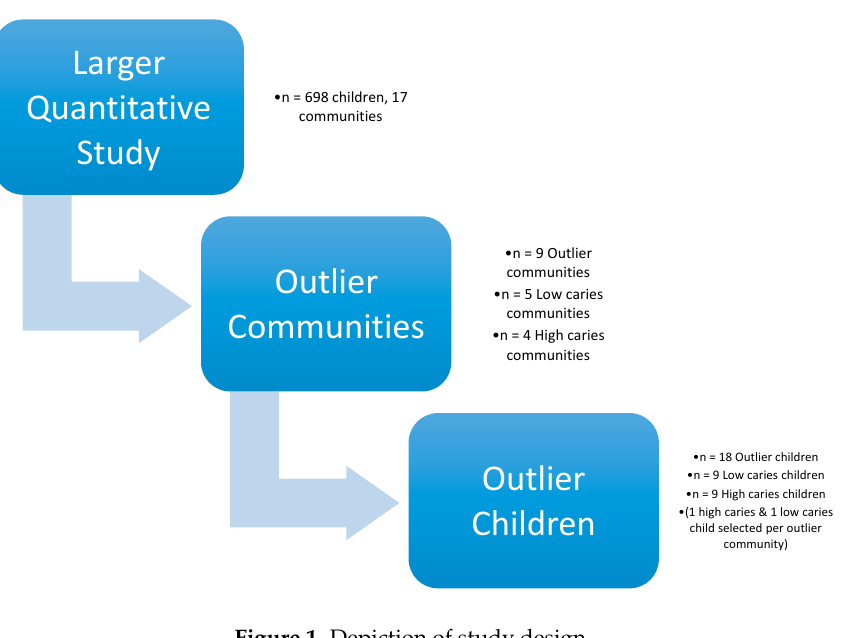
Figure 1. Depiction of study design.